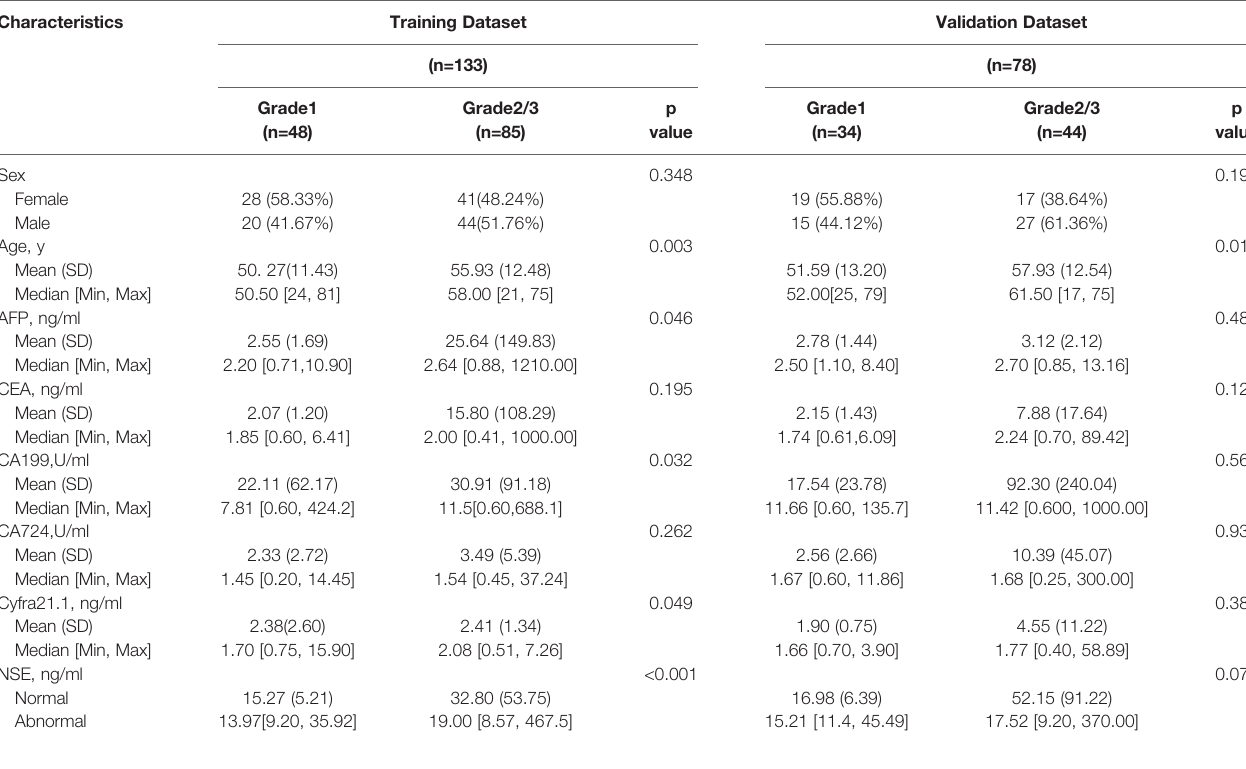
TABLE 2 | Characteristics of patients with GEP-NETs in the G1 group and G2/3 group.